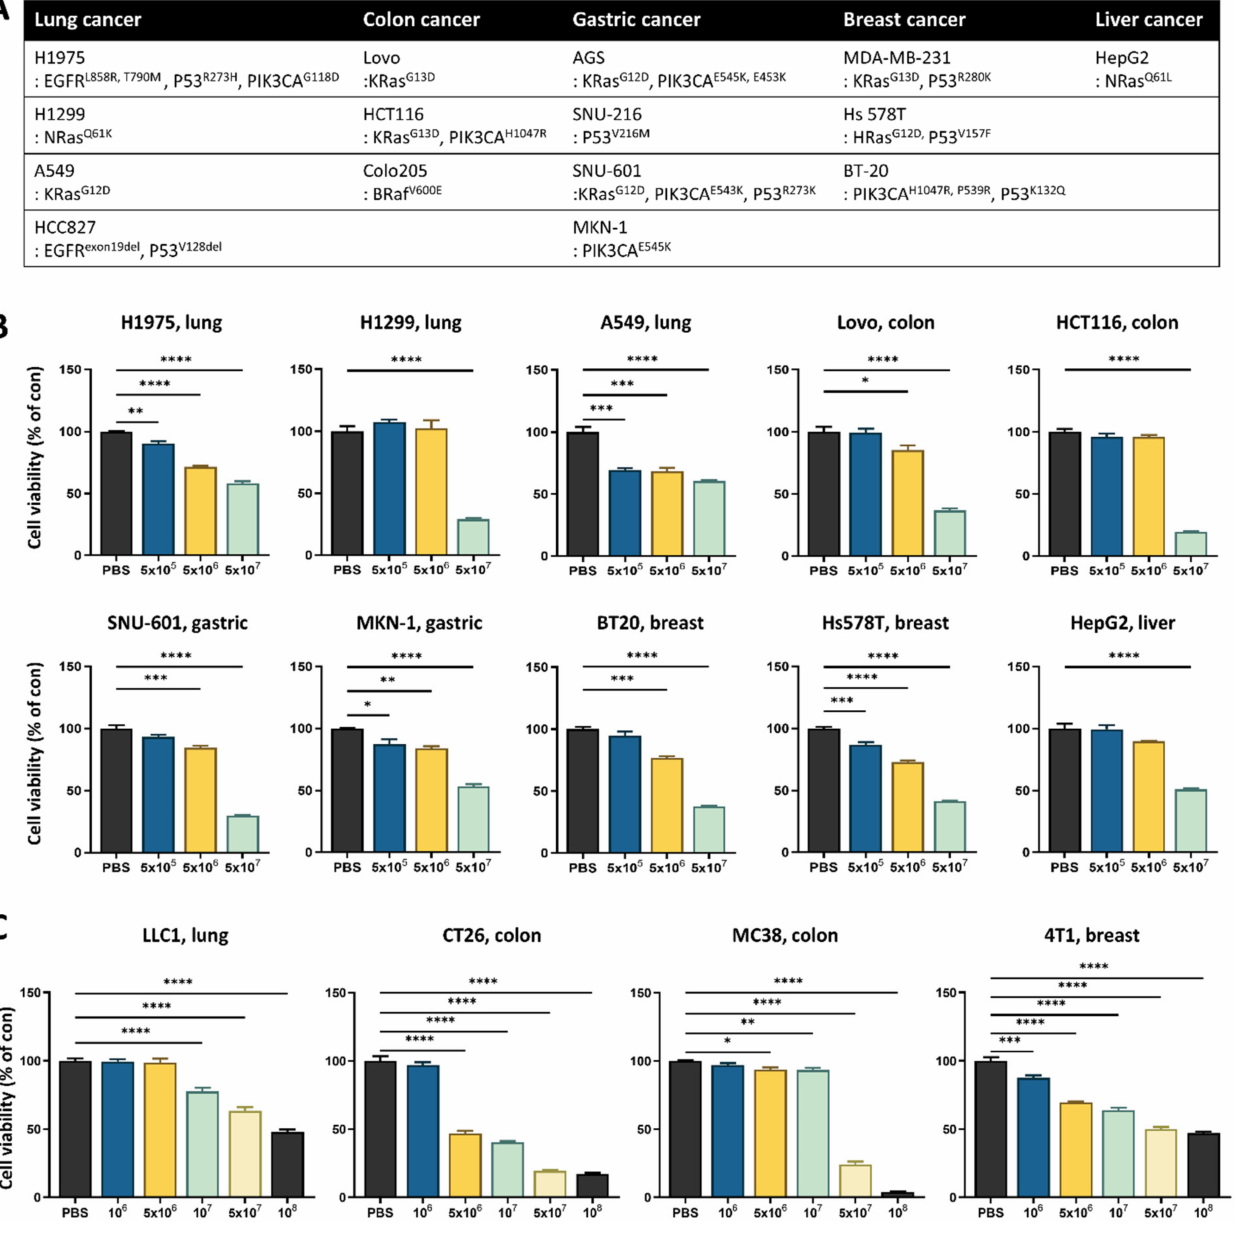
Figure 1. Lactococcus lactis GEN3013 induces the death of various cancer cells. ( A ) Human cancer cell lines were organized according to the cancer type and genetic characteristics. ( B , C ) Various human and mouse cancer cell lines were treated with 0.5% L. lactis GEN3013 dose-dependently and incubated for 72 h. Cell viability was measured using an MTT assay and calculated relative to a PBS control. All human and mouse cancer cells showed significant p -values ( p ≤ 0.0001) according to one-way ANOVA tests. Data represent relative cell viability ± SEM; the p -values were calculated using one-way ANOVA with Tukey’s multiple comparison test compared to a PBS control; * p ≤ 0.05, ** p ≤ 0.01, *** p ≤ 0.001, and **** p ≤